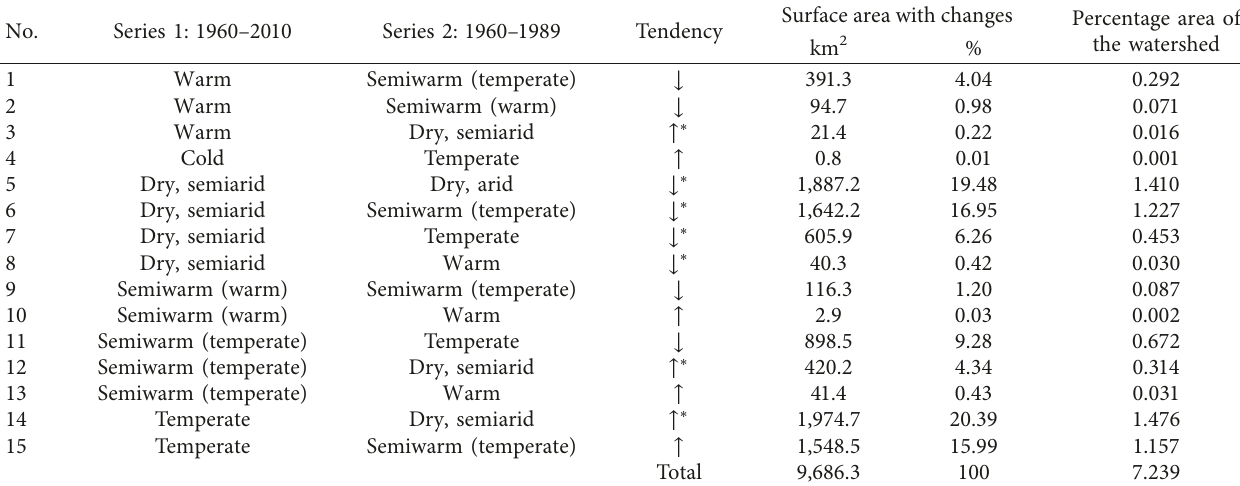
The behavior of rainfall can contribute considerably toward variations in temperature characterization. ∗